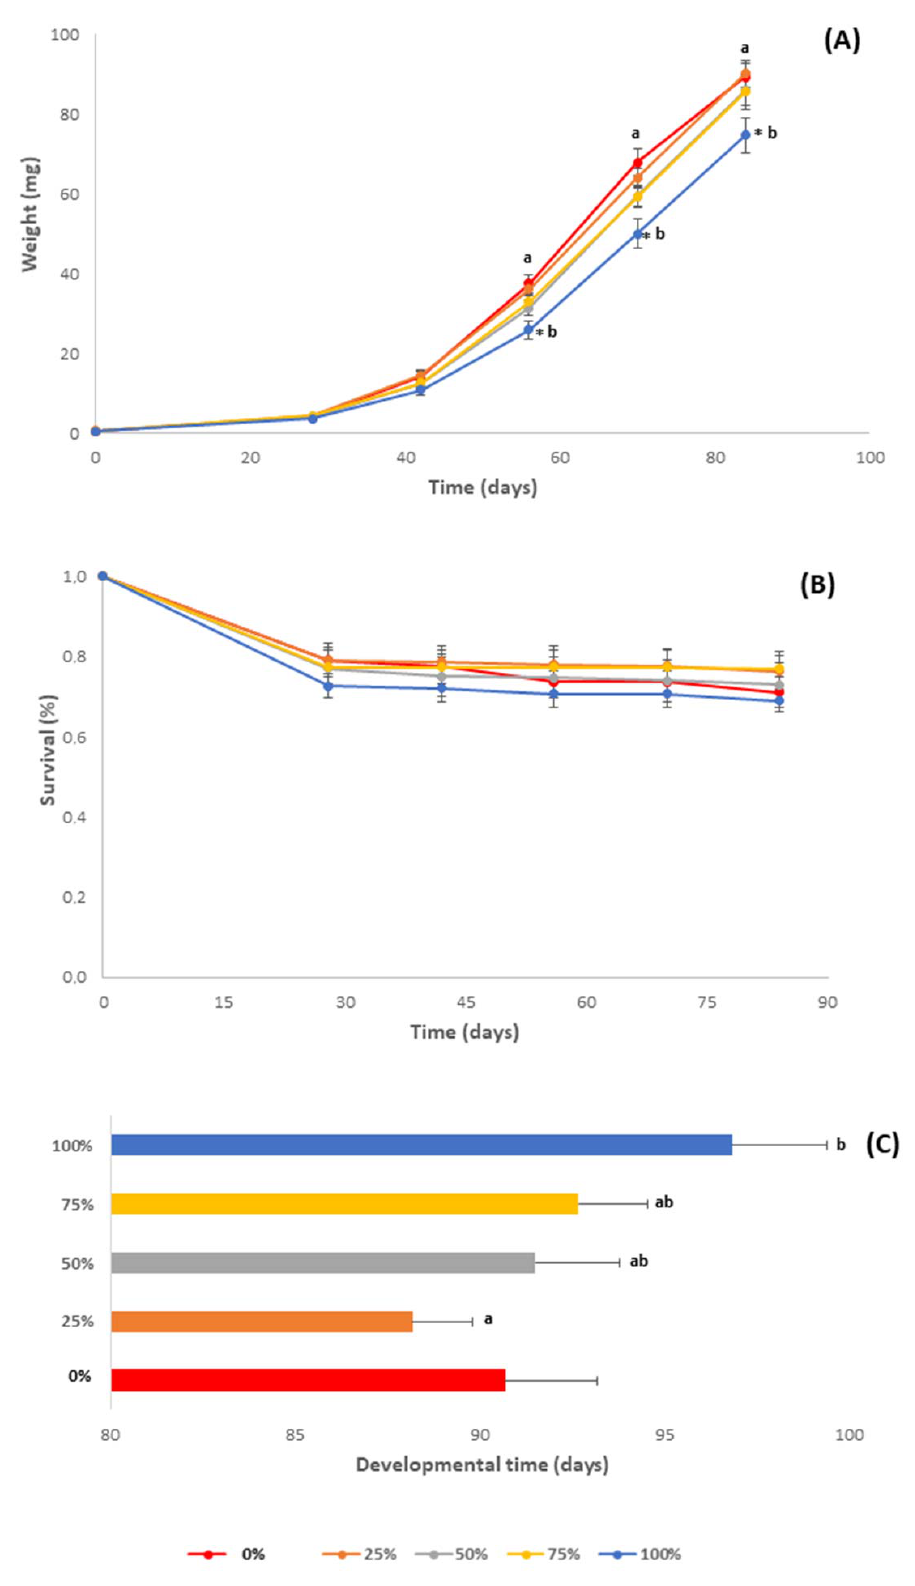
Figure 3. ( A ) Average larval weight (mg), ( B ) survival rate (%) and ( C ) development time (days) of Tenebrio molitor larvae reared on substrates containing different content levels of milled carob pods (0, 25, 50, 75 and 100%). In all cases, values represent means ± SE ( n = 6). Asterisk (*) indicates p < 0.05 compared to 0%, while lower case letters indicate p < 0.05 compared to different carob contents (%).